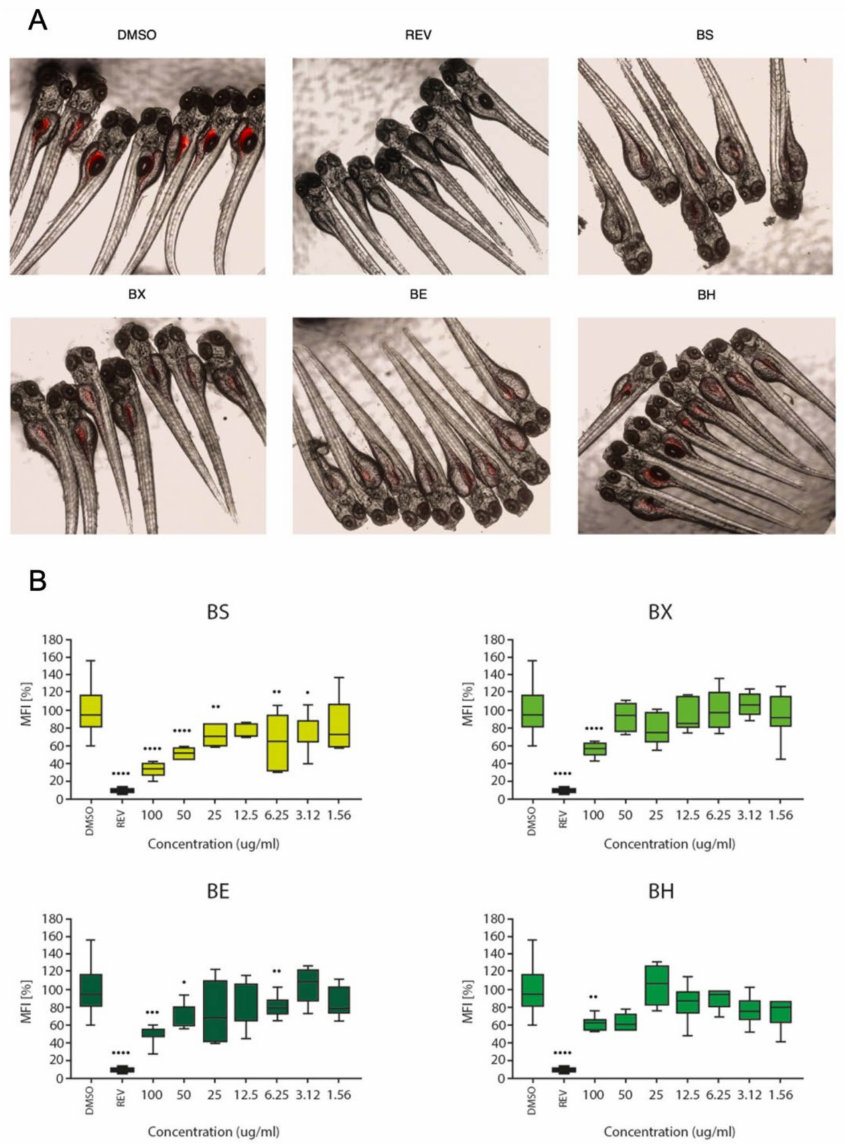
Figure 5. ( A ) Zebrafish Nile red fat metabolism assay representation with a strong fluorescence signal from the solvent control (DMSO) around the yolk sac and stomach in the zebrafish larvae. BS, BE, BX and BH fractions decreased Nile red staining at the highest concentration tested (100 µ g/mL). ( B ) Quantification of the lipid-reducing activity in the zebrafish Nile red fat metabolism assay after 48 h exposure. A solvent control (0.1% dimethyl sulfoxide, DMSO) and positive control (50 µ M resveratrol, REV) were included in the bioassay. Six to eight individual larvae per treatment group were used (n = 6–8). Values are expressed as mean fluorescence intensity (MFI) relative to the solvent control group. The data are represented as box-whisker plots from the 5th to 95th percentiles